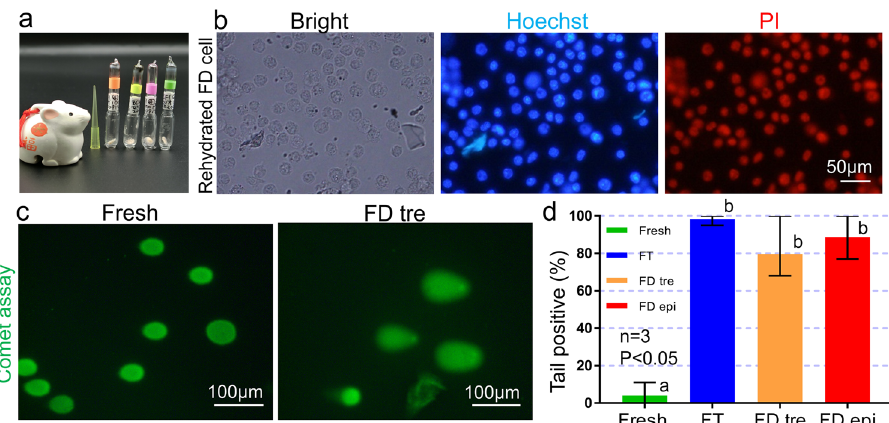
Fig. 2 FD ampoules and DNA damage of FD somatic cell nuclei. a Ampoules of FD somatic cells. b Damaged cell membrane after rehydration. Left: bright fi eld; middle: Hoechst staining; right: propidium iodide (PI) staining. n = 4 biologically independent ampoules. c , d Comet DNA breakage assays of FD somatic cell nuclei. FT: Freeze-thaw. FD-tre: Freeze-dry with trehalose. FD-epi: Freeze-dry with epigallocatechin. n = 3 biologically independent experiment. a vs. b : P < 0.05 (one-way ANOVA and Tukey-multiple comparison-test). See Supplementary Table 1 for more details. Data are presented as mean value, minima and maxima.